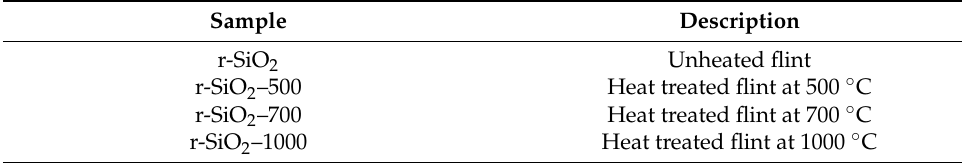
Figure 1. The procedure of heat treatment. Table 1. Sample description.